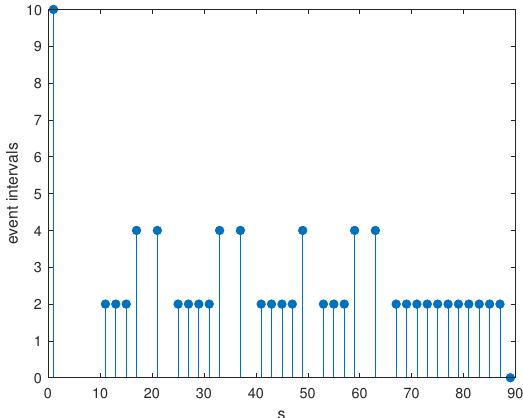
Figure 12. Release intervals with ˆ K and Ω